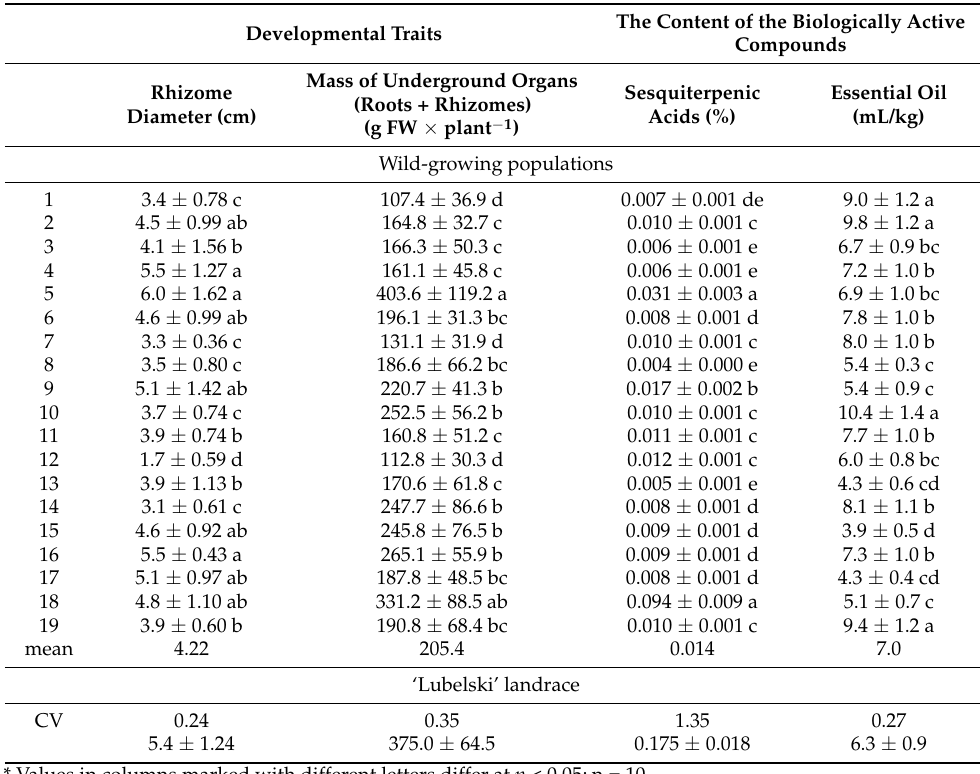
The Content of the Biologically Active Compounds Sesquiterpenic Essential Oil Acids (%) (mL/kg)